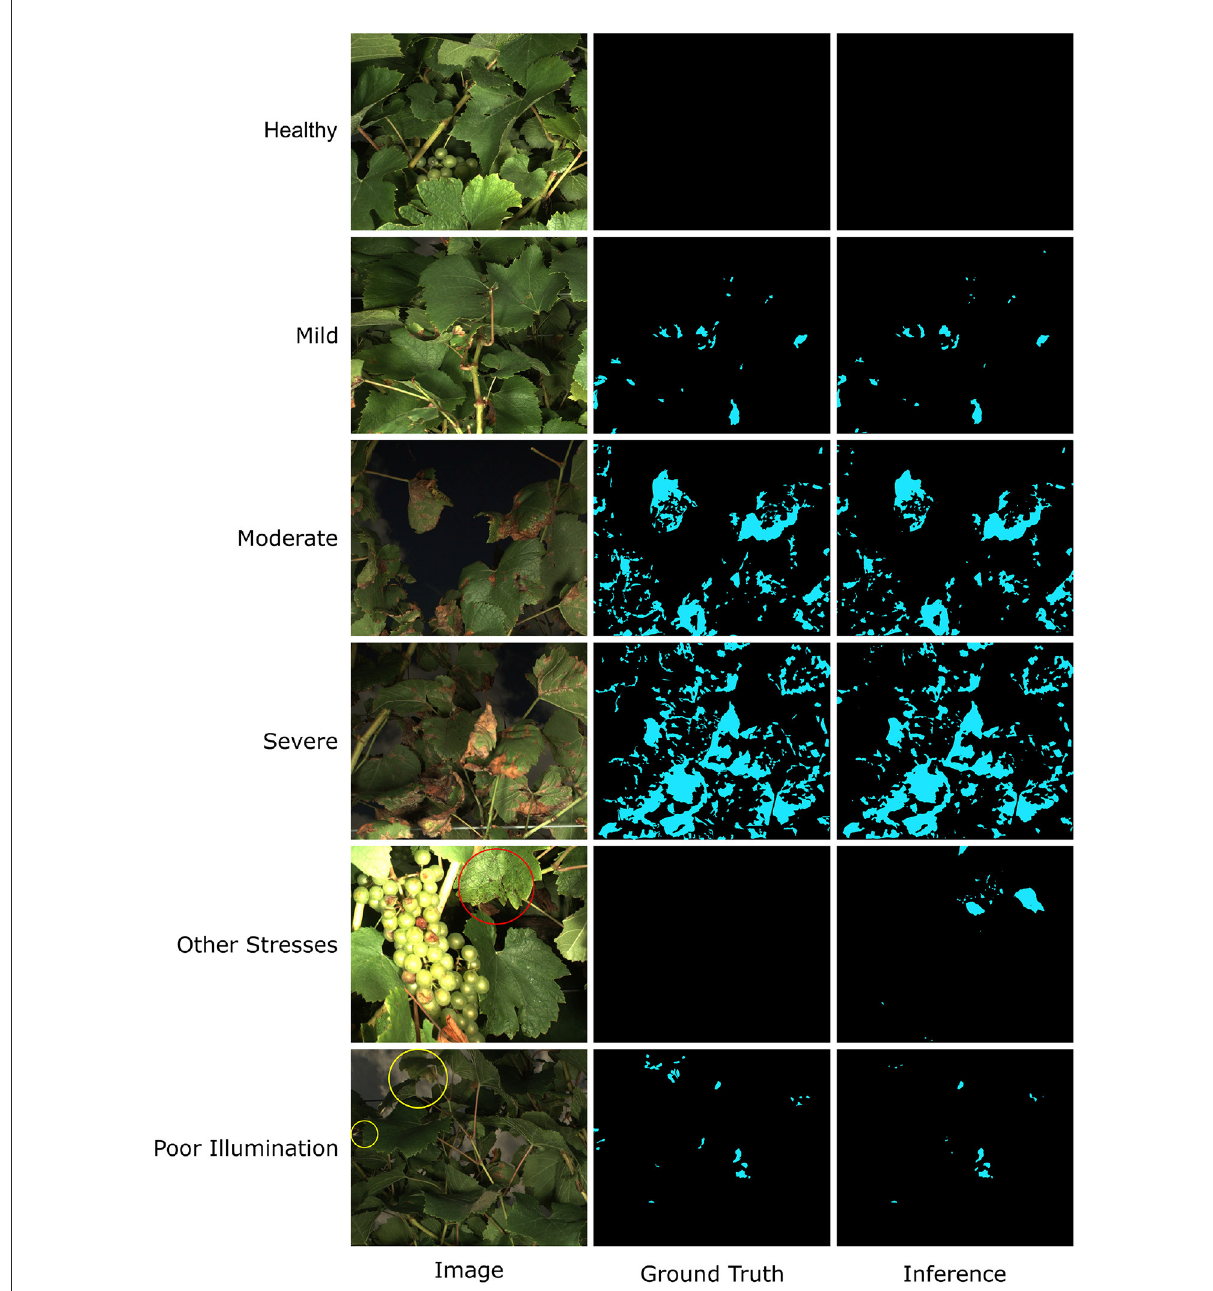
FIGURE6 Examples of Downy Mildew (DM) infection segmentation mask generated by HMASS. Images are selected from testing dataset. Ground truth are manually labeled. Red circle indicates region of non-DM damage confused by the inference model. Yellow circles are false negative detections due to insufficient lighting